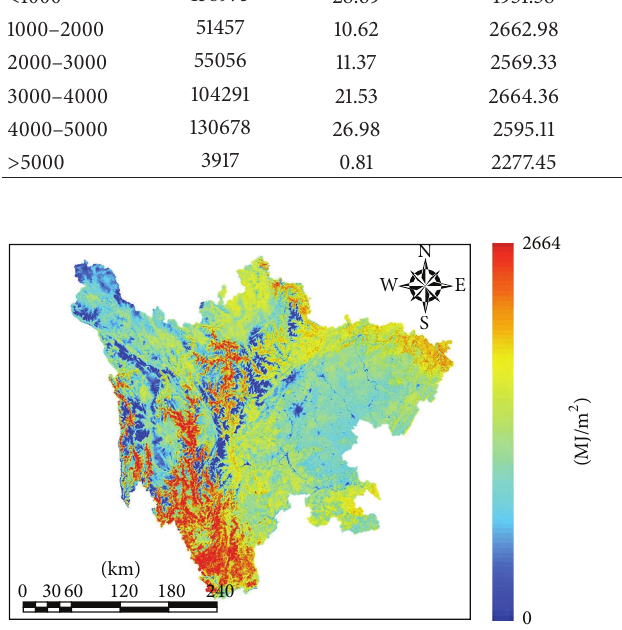
Figure 3: Distribution of APAR for Sichuan province in 2011.